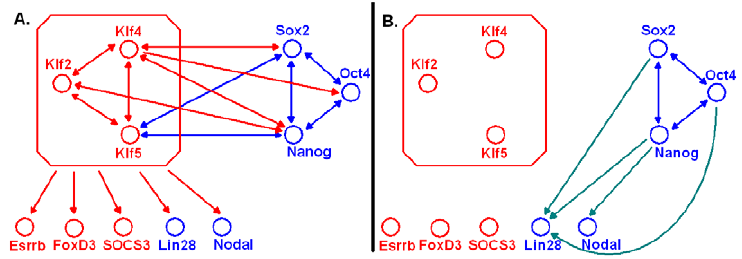
Figure 4. Rewiring of the KLF regulatory module. Nodes represent upregulated genes in ES cells in a conserved (blue, upregulated in both hES and mES cells) or species-specific (red, upregulated in mES cells only) manner. Edges represent positive regulatory relationships (activation) that are validated by ChIP-chip and RNAi data in both species (dark blue), in mouse only (red), or in human only (light blue). As the KLF module appears to have lost its regulatory function in hES cells, its target genes ESRRB , FOXD3 and SOCS3 have consistently lost their upregulation in hES cells as well (A). However, LIN28 and NODAL , which are upregulated by the KLF module in mES cells, remain upregulated in hES cells. Their upregulation in hES cells might be activated by NANOG and OCT4 instead